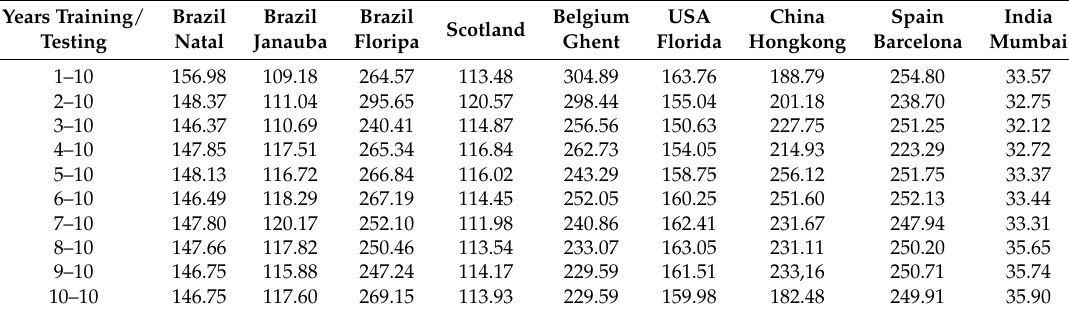
Table 2. RMSE error on the testing set at different locations and